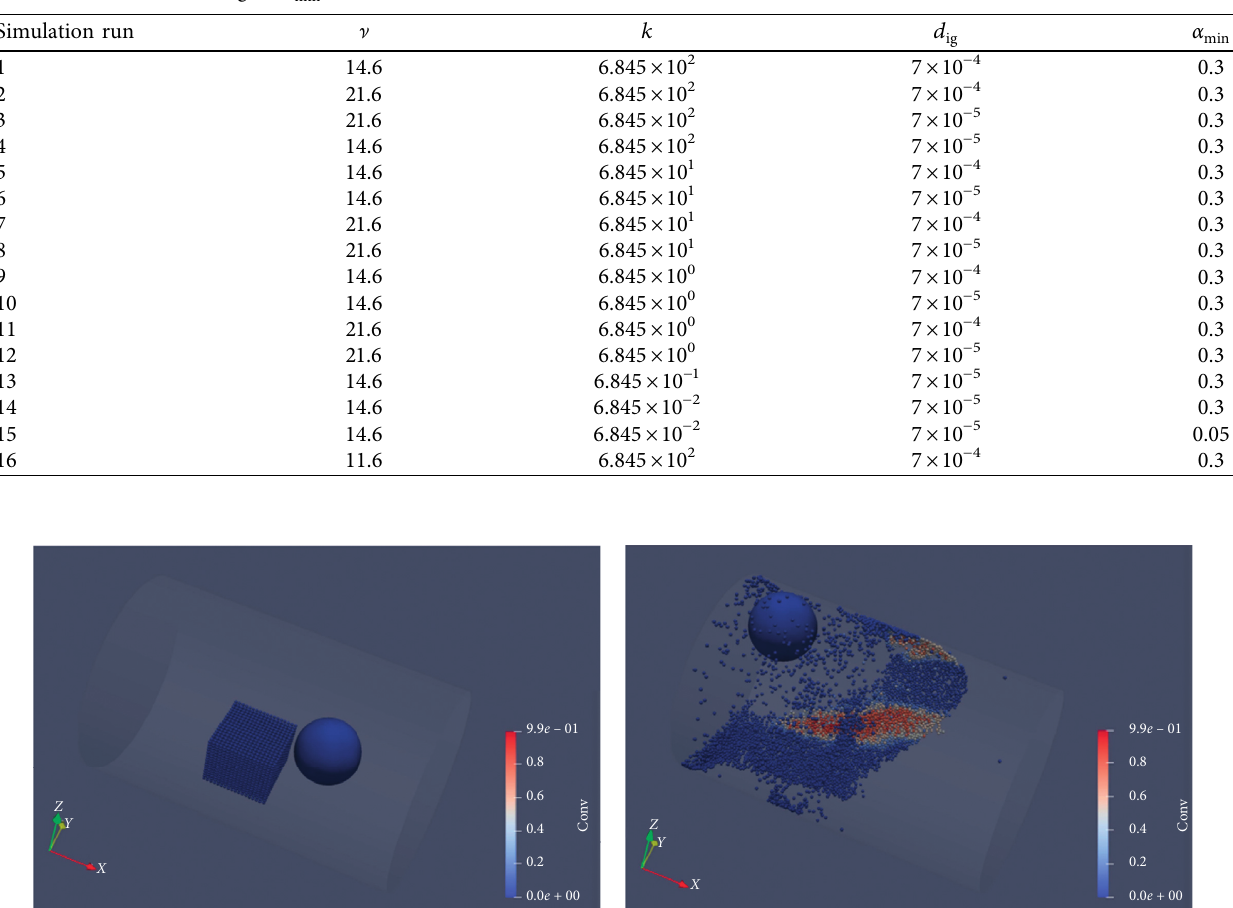
(m), and the lower ignition ig